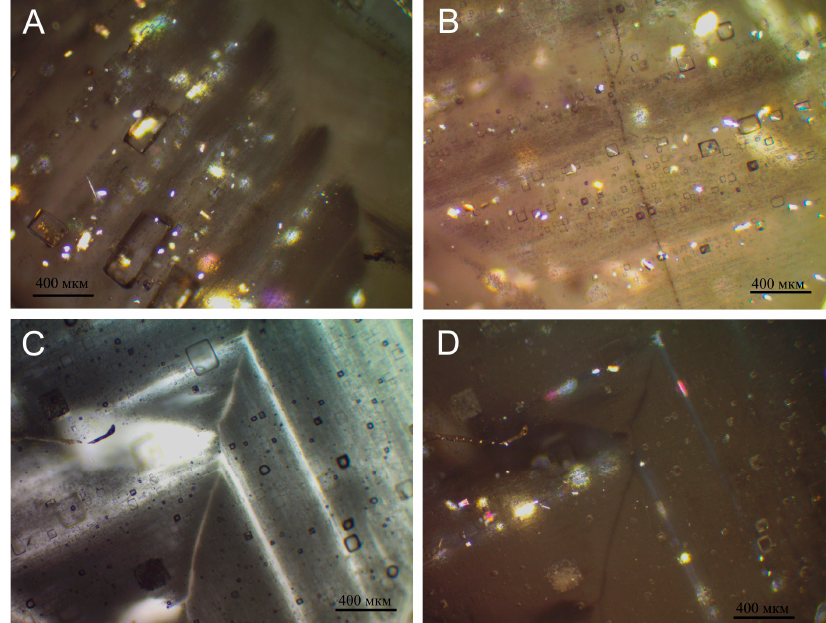
Figure 9. Gypsum nucleation during the formation of bottom-grown halite. ( A, B ) Nucleation during the day–night period; sample No. 6 ( A ); sample No. 1 ( B ); XPL crossed polarized light. ( С , D ) Nucleation mainly during the night; sample No. 7 ( С ) PPL plane polarized light; sample No. 7 ( D ), XPL crossed polarized light.